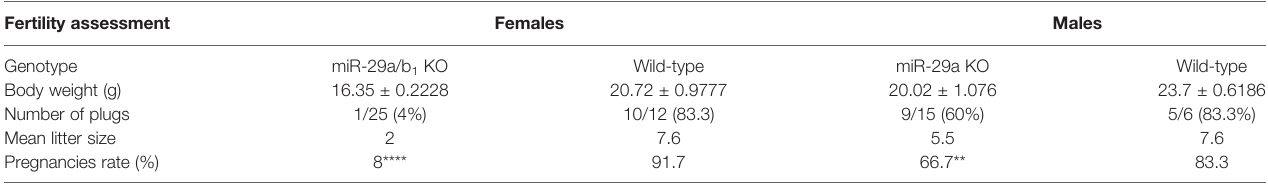
TABLE 1 | Fertility assessment. Body weight, number of plugs, offspring and pregnancy rate based on mating of wild-type male and female mice. Fertility